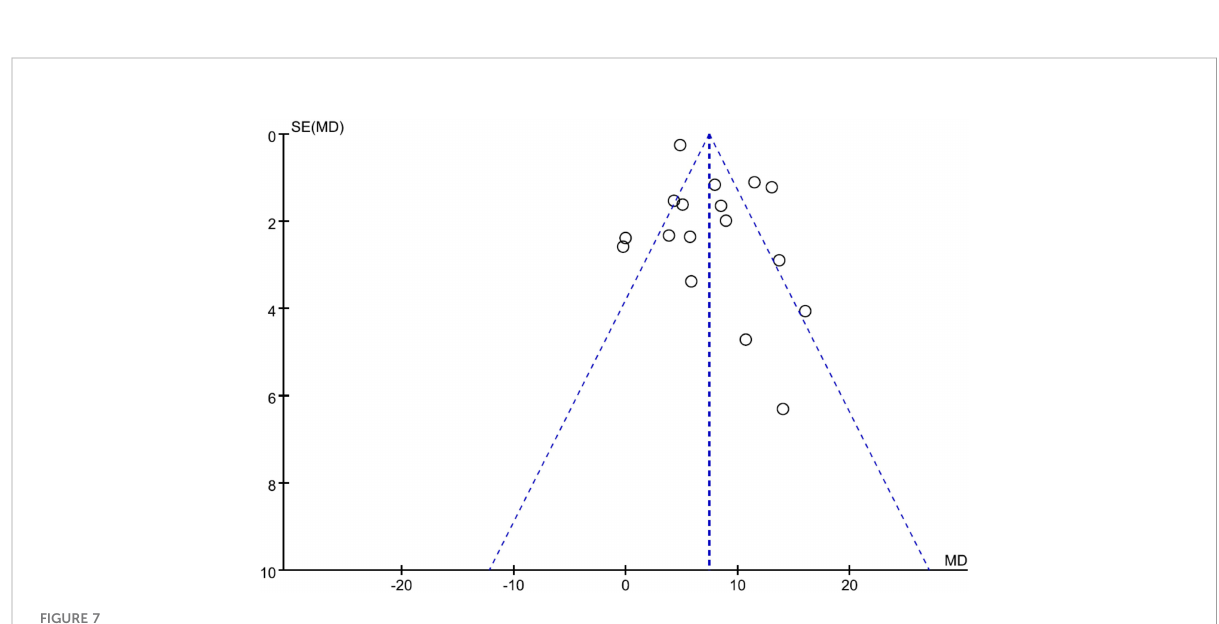
FIGURE 7 Funnel plots of publication bias for the number of retrieved lymph